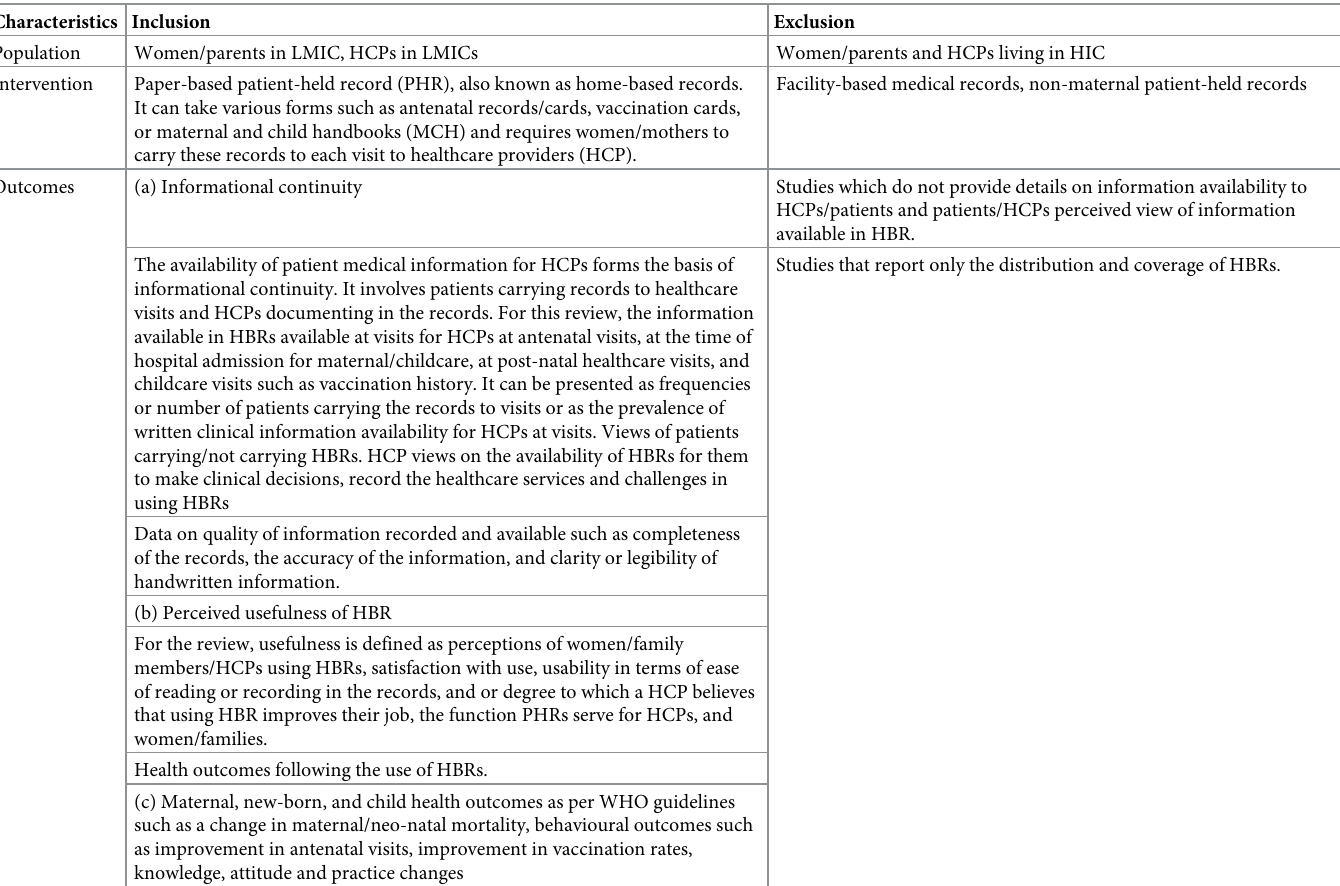
Table 1. Inclusion and exclusion criteria for